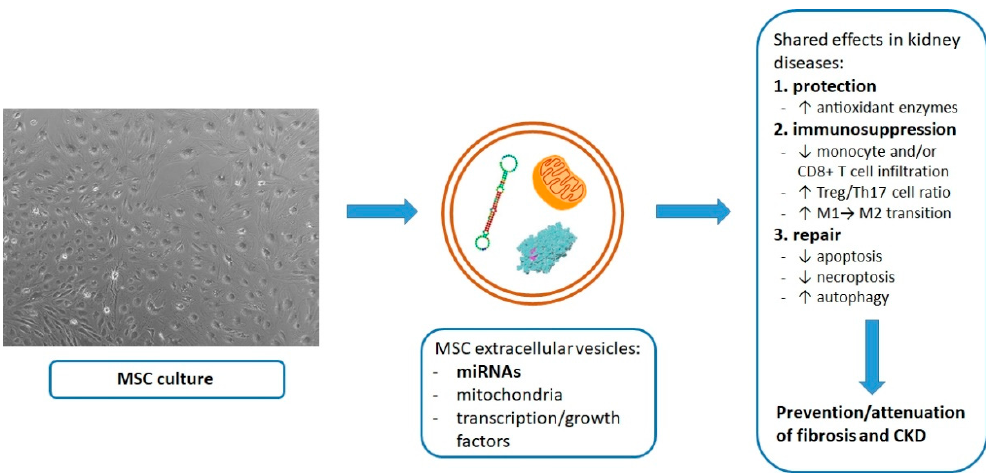
Figure 1. Shared major mechanisms of nephroprotection with exogenous MSC/MSC-derived products in renal diseases.